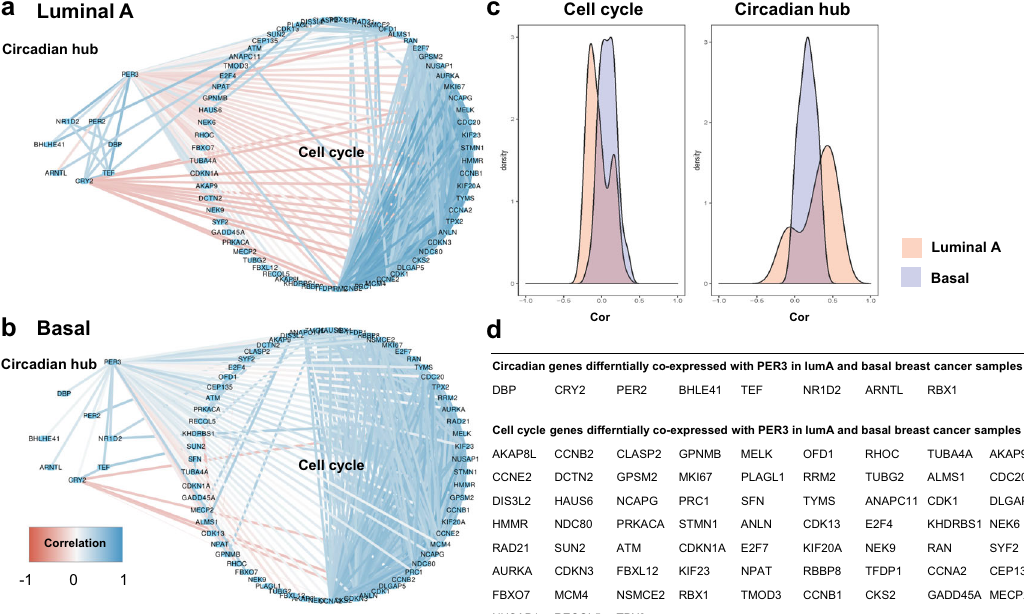
Fig. 4 Differences in PER3 co-expression structure between luminal A and basal breast cancer samples. a PER3 co-expression network in lumninal A breast cancer samples including cell cycle and circadian hub genes found to be differentially co-expressed in luminal A and basal breast cancer samples. b PER3 co-expression network in basal breast cancer samples including cell cycle and circadian hub genes found to be differentially co-expressed in luminal A and basal breast cancer samples. c Densities of the correlations between PER3 and both the eight circadian related genes found to be differentially co-expressed between the LumA and the basal subtypes (left plot) and the 66 cell cycle genes found to be differentially co-expressed between LumA and Basal (right plot). d Table depicting the list of genes linked to the circadian hub and the cell cycle found to be differentially correlated with PER3 in luminal A and basal breast cancer